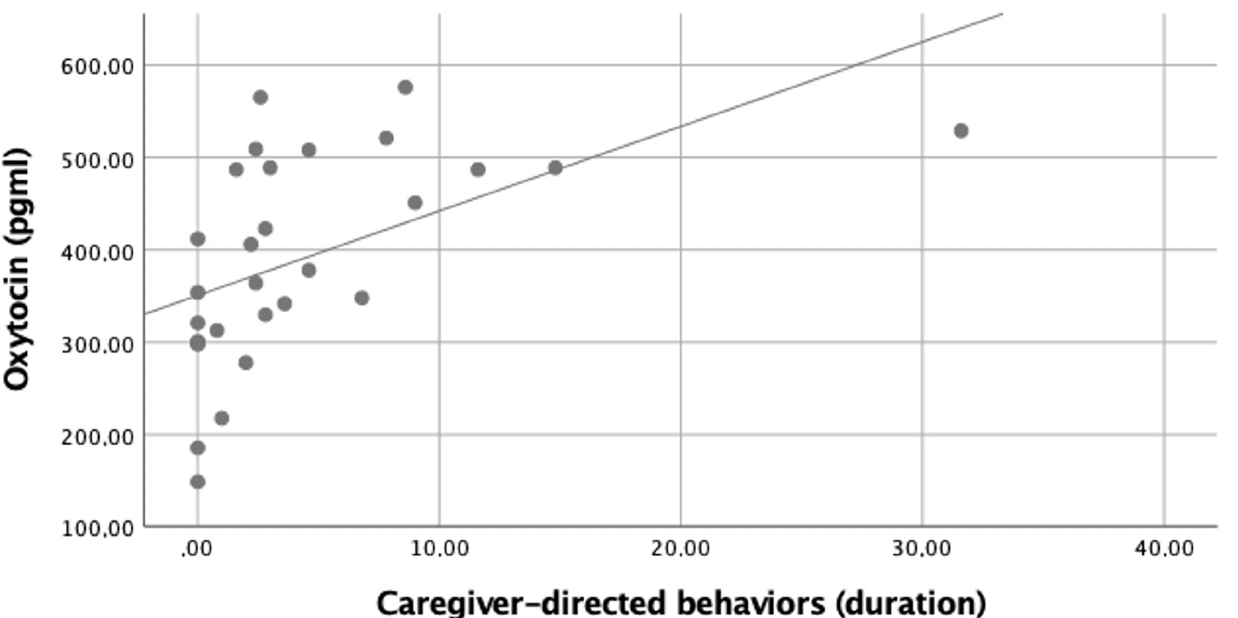
Figure 1. Simple scatter with fit line of serum oxytocin levels by the duration of the caregiver-directed behaviors. Spearman correlations between variables ρ = 0.699 ( p < 0.001 with Bonferroni correction). Table 2. Spearman correlations between oxytocin, cortisol, and behavioral variables (duration). Asterisks indicate a significant correlation. Sample size: 29 cows.